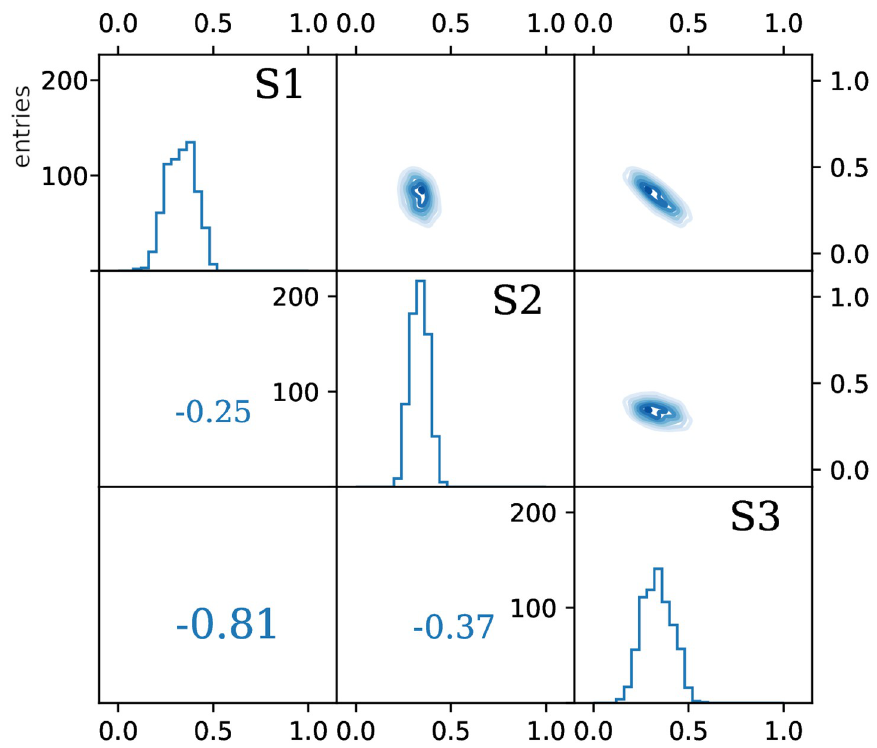
Fig 5. Histograms (on the diagonal) calculated from the variables building the Markov chains along with their correlations as contour-plots (top-right) and correlation coefficients (bottom-left). See the text for a more detailed analysis of the data shown.